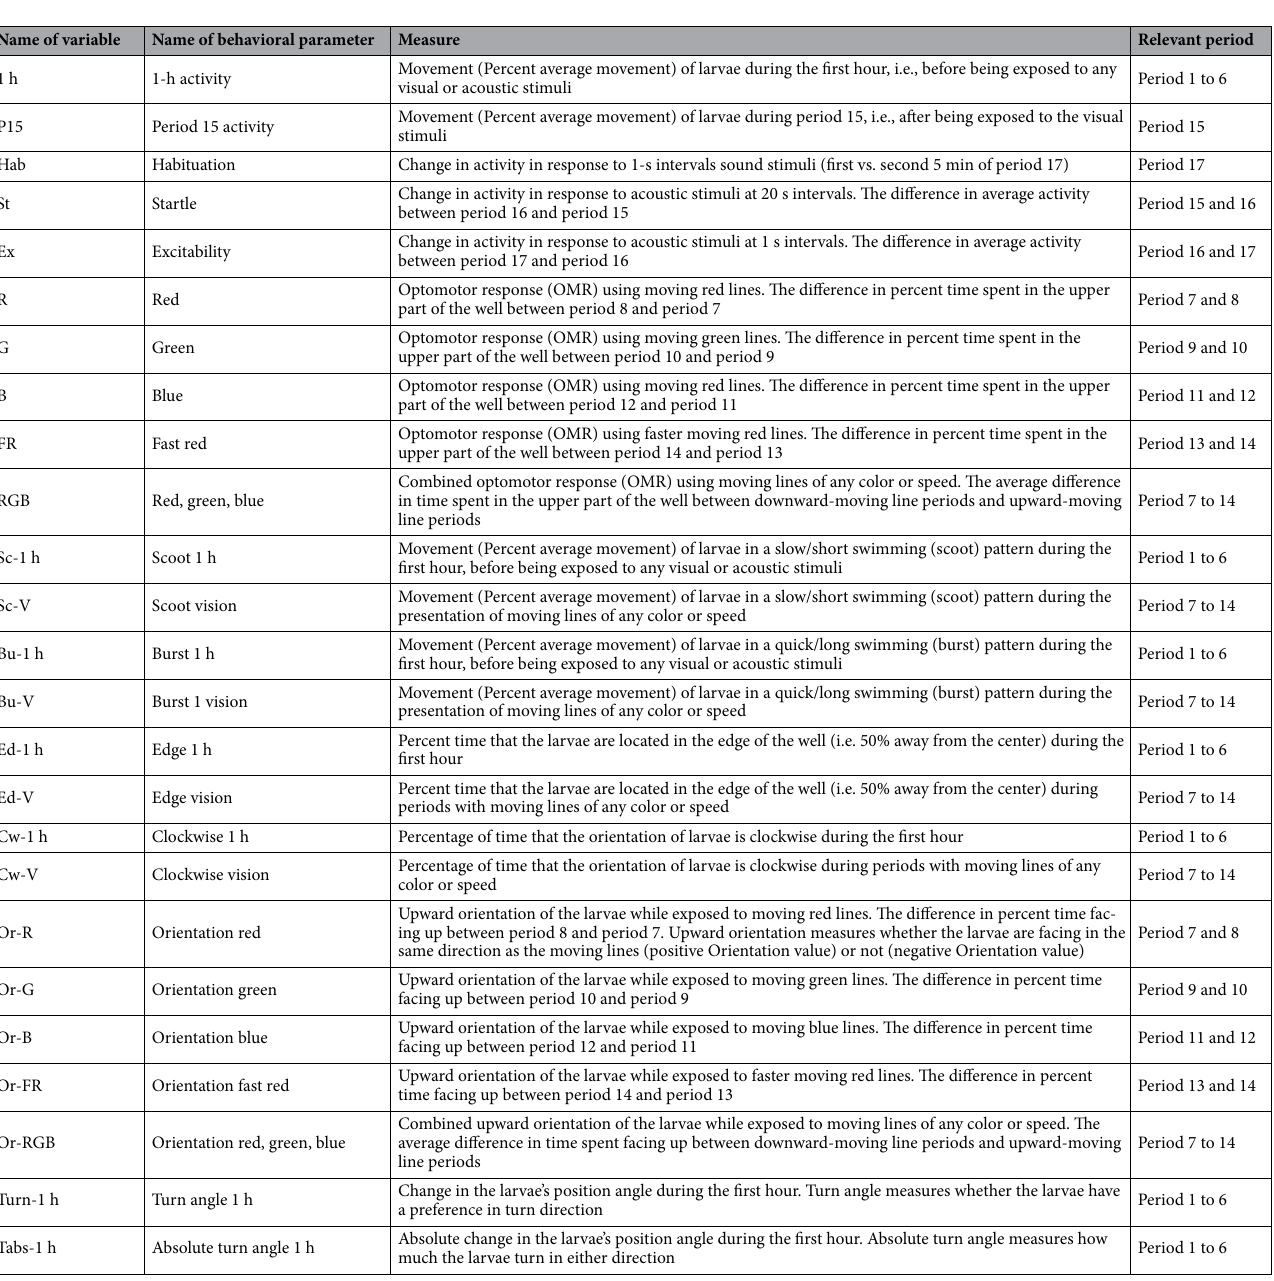
Percent time that the larvae are located in the edge of the well (i.e. 50% away from the center) during the first hour Percent time that the larvae are located in the edge of the well (i.e. 50% away from the center) during periods with moving lines of any color or speed Percentage of time that the orientation of larvae is clockwise during the first hour Percentage of time that the orientation of larvae is clockwise during periods with moving lines of any color or speed Upward orientation of the larvae while exposed to moving red lines. The difference in percent time fac- ing up between period 8 and period 7. Upward orientation measures whether the larvae are facing in the same direction as the moving lines (positive Orientation value) or not (negative Orientation value) Upward orientation of the larvae while exposed to moving green lines. The difference in percent time facing up between period 10 and period 9 Orientation blue Upward orientation of the larvae while exposed to moving blue lines. The difference in percent time facing up between period 12 and period 11 Orientation fast red Upward orientation of the larvae while exposed to faster moving red lines. The difference in percent time facing up between period 14 and period 13 Combined upward orientation of the larvae while exposed to moving lines of any color or speed. The Orientation red, green, blue average difference in time spent facing up between downward-moving line periods and upward-moving line periods Change in the larvae’s position angle during the first hour. Turn angle measures whether the larvae have a preference in turn direction Absolute turn angle 1 h Absolute change in the larvae’s position angle during the first hour. Absolute turn angle measures how much the larvae turn in either